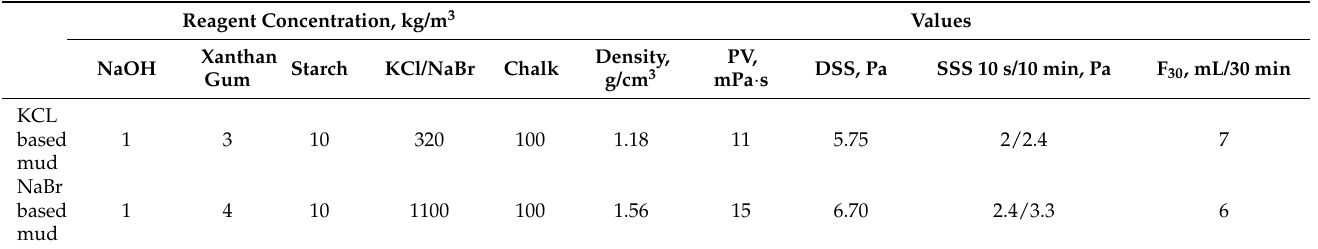
Table 1. Reagent concentrations and values for parameters of drilling muds.